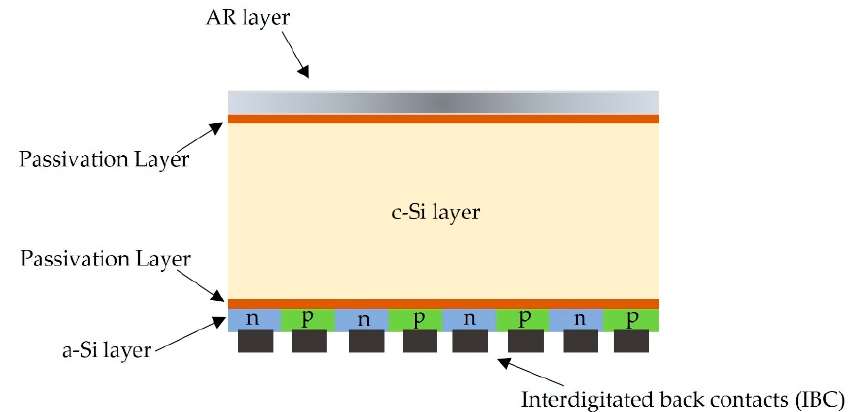
Figure 6. Cross-section of an HJ-IBC solar cell.